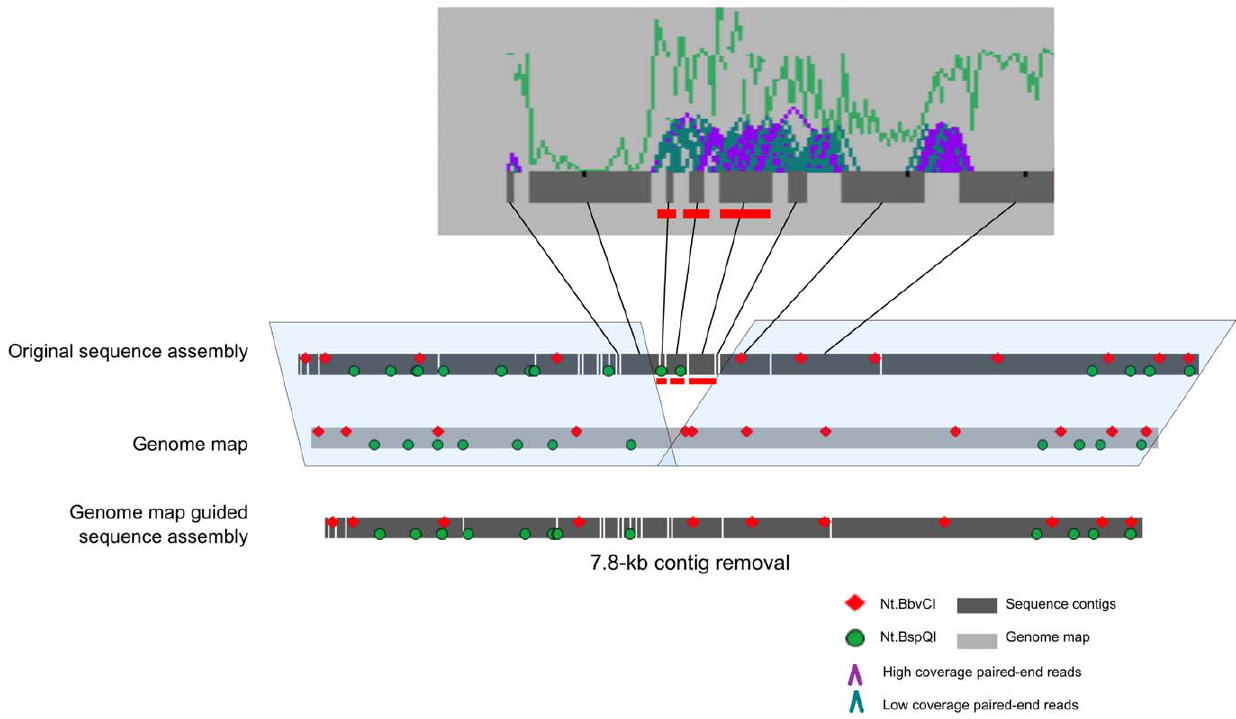
Figure 3. Deletion of incorrect contigs in genome map-guided denovo sequence assembly. The original assembly contained two Nt.BspQI sites and , 8 kb of sequence that were absent from the genome map. The top image is output from gsAssembler and shows the scaffolding of contigs using paired-end reads. The green line represents the sequence coverage for each region. Paired-end reads are represented by pink (high coverage) and aqua (low coverage) carrots (&squ;). The three contigs with red bars beneath them contain the extra sequence motifs and total sequence consistent with the predicted incorrect scaffold. They also contain weak paired-end data indicating that the contigs are misplaced. The bottom line shows the sequence assembly after deletion of the three contigs with red bars.